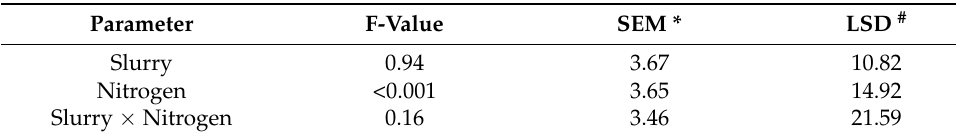
Table 10. 2016/17 REML analysis total N offtake